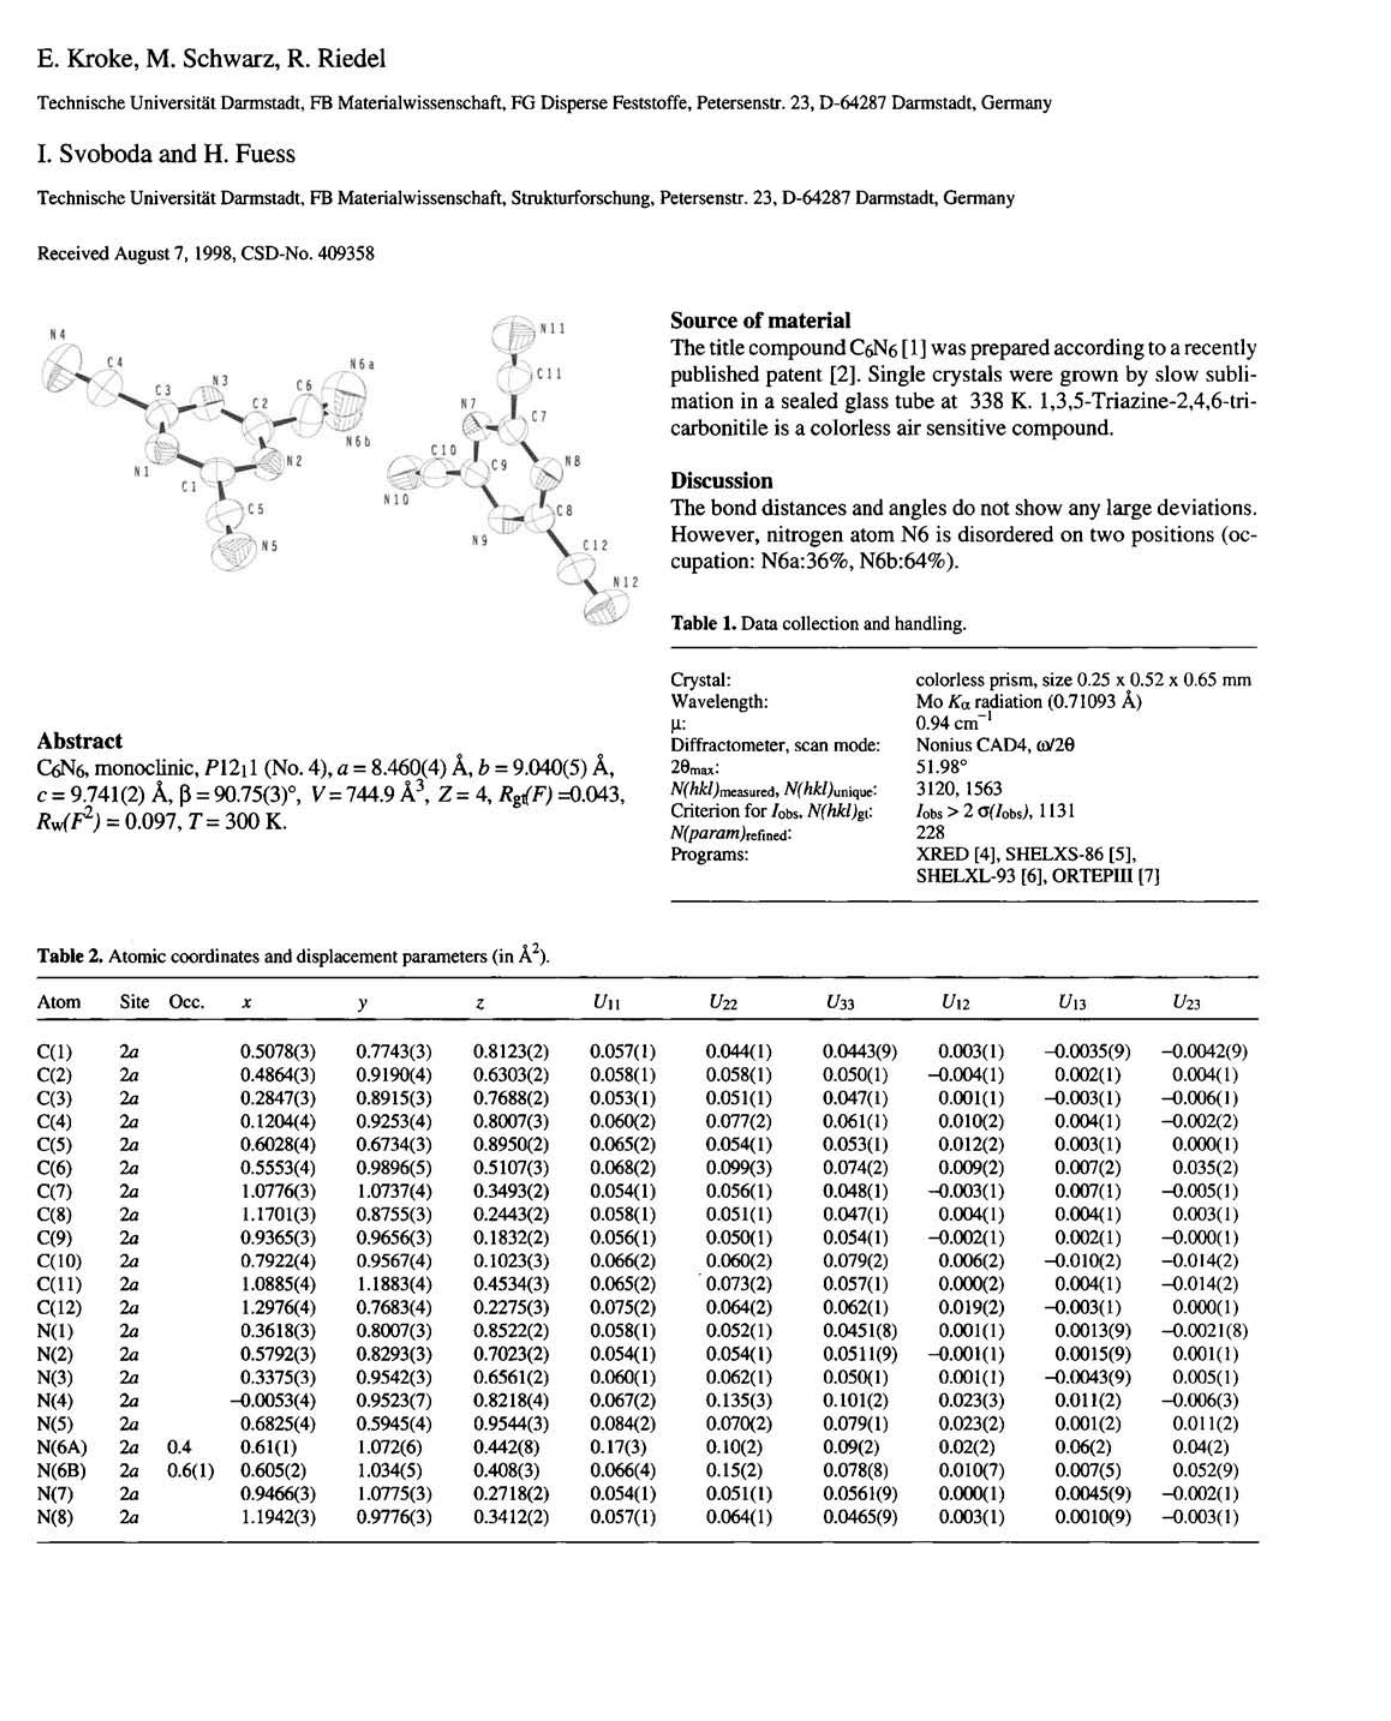
Table 1. Data collection and handling.